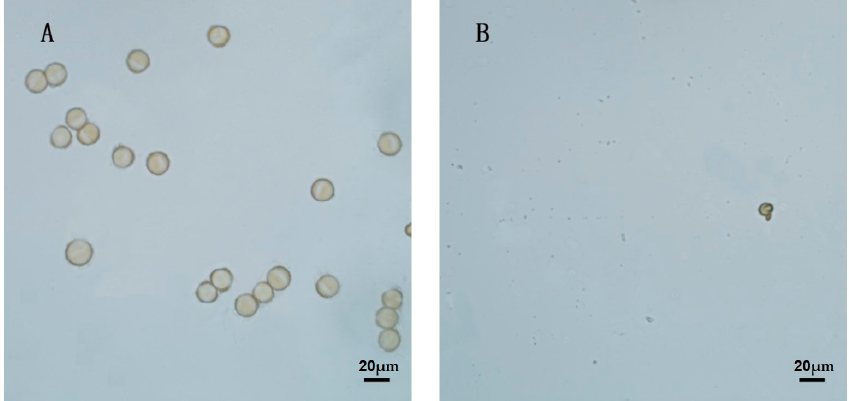
Figure 4. Pollen viability determination of Brcd1 YS and YS. Pollen viability determination of Brcd1 YS and YS. ( A ): YS, ( B ): Brcd1 YS . Scale bars = 20 μ m.